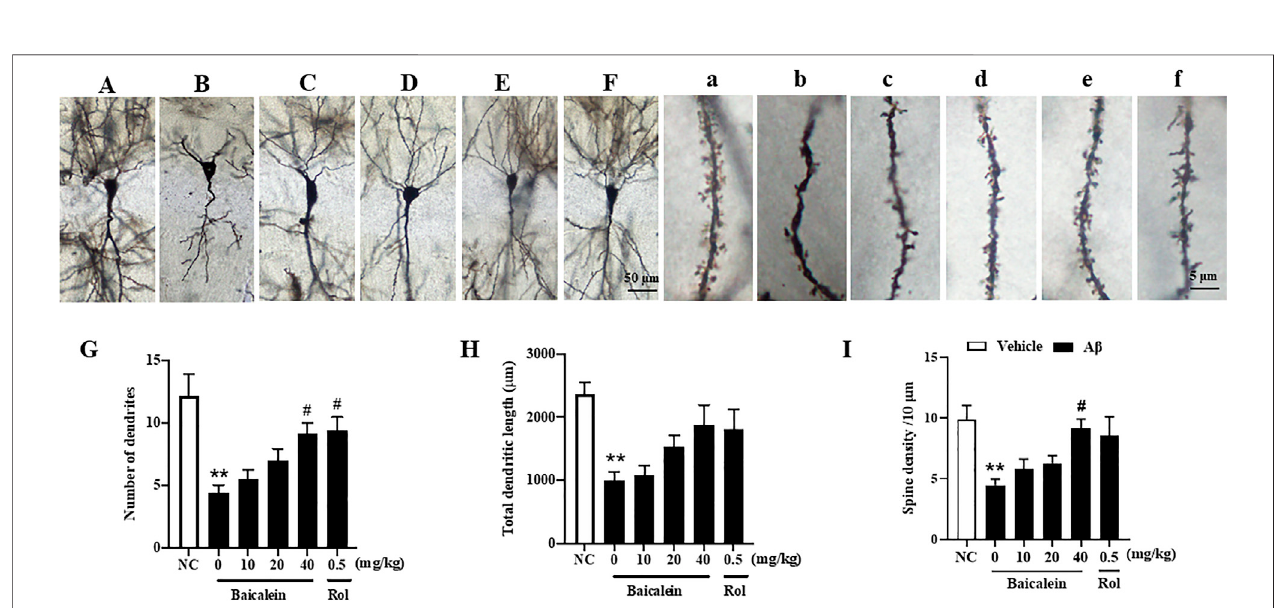
FIGURE5| Baicalein improved hippocampal neuronal remodeling of A β -treated mice in the rapid Golgi staining assay. (A – F) and (a – f) Rapid Golgi staining showed increased neuroplasticity of the CA1 pyramidal neurons in the hippocampus (scale bars (cid:2) 50 and 5 µm). (G) The number of dendrites, (H) total dendritic length, and (I) spine density per 10 μ m were increased by baicalein treatment in A β -treated mice. All values were expressed as mean ± SEM ( n (cid:2) 6). ** p < 0.01 vs. NC mice; # p < 0.05 vs. A β -treated mice.